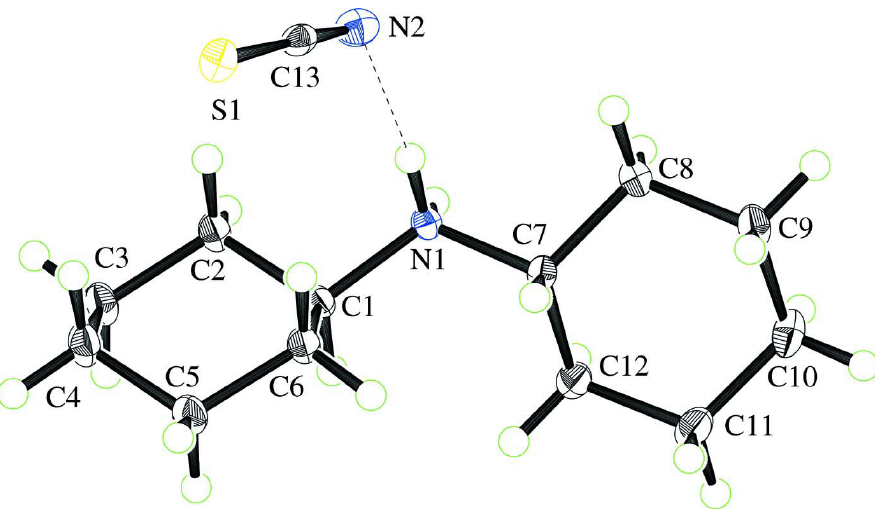
Figure 1 Molecular structure of (I) showing atom-labelling scheme and displacement ellipsoids at the 30% probability level.